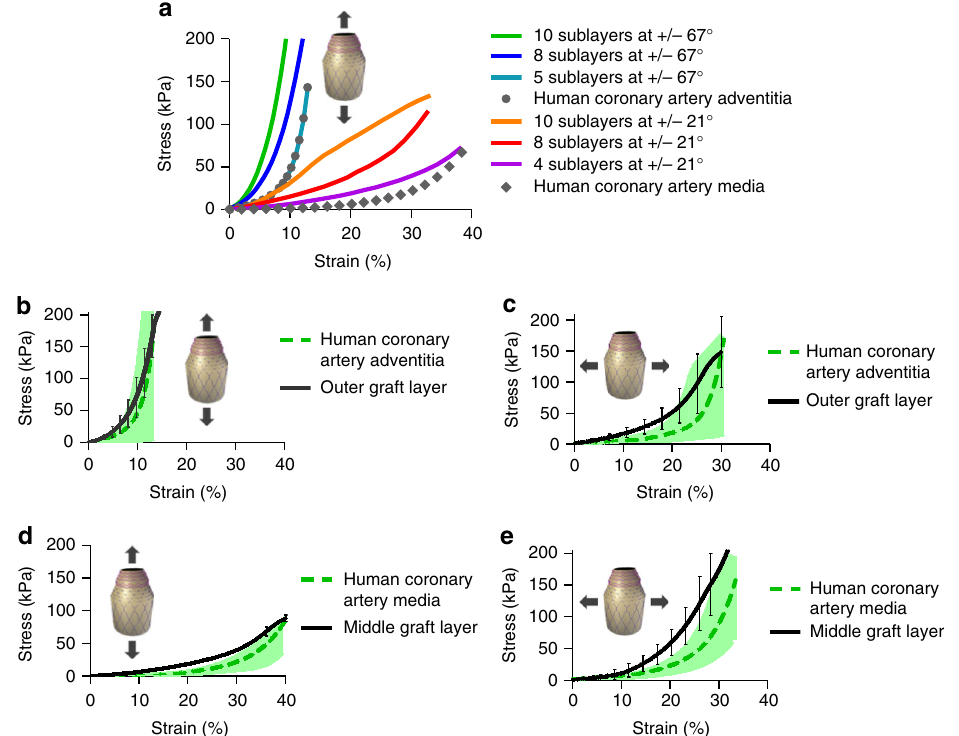
Fig. 5 Stress – strain curves of the outer and middle graft layers based on methacryloyl gelatin-alginate (GEAL) reinforced poly( ε - caprolactone) (PCL) sublayers. a Iterative improvement of the middle and outer graft layers: longitudinal tensile testing of the middle and outer graft layers using different numbers of middle and outer graft sublayers in the construct. Grey dotted lines represent the average longitudinal stress – strain curve of the native adventitia (closed circles) and media (closed diamonds) layer of human coronary arteries 11 . b , c Longitudinal and circumferential stress – strain curve of the outer graft layer composed of fi ve graft (GEAL/PCL) sublayers. Green dashed lines in b , c represent the average longitudinal and circumferential stress – strain curves of the native media layer of coronary arteries 11 , respectively. d , e Longitudinal and circumferential stress-strain curve of the middle graft layer composed of four graft (GEAL/PCL) sublayers. The green dashed lines in d , e represent the average longitudinal and circumferential stress – strain curve of the native adventitia layer of human coronary arteries 11 , respectively ( n = 3). The shaded green zones in the fi gures represent the range of results obtained for native human coronary arteries 11 . Error bars = standard deviation; n = 3 independent